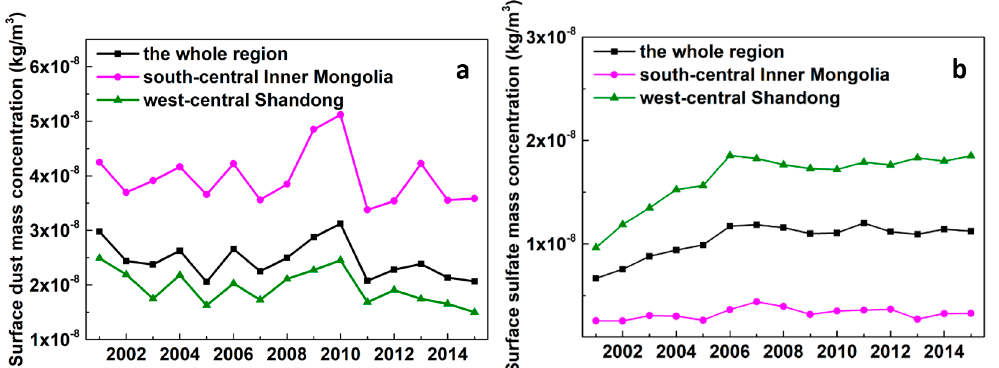
Figure 17. Variations of annual surface ( a ) dust and ( b ) sulfate mass concentration in south-central Inner Mongolia, west-central Shandong, and the whole study area from 2001 to 2015.